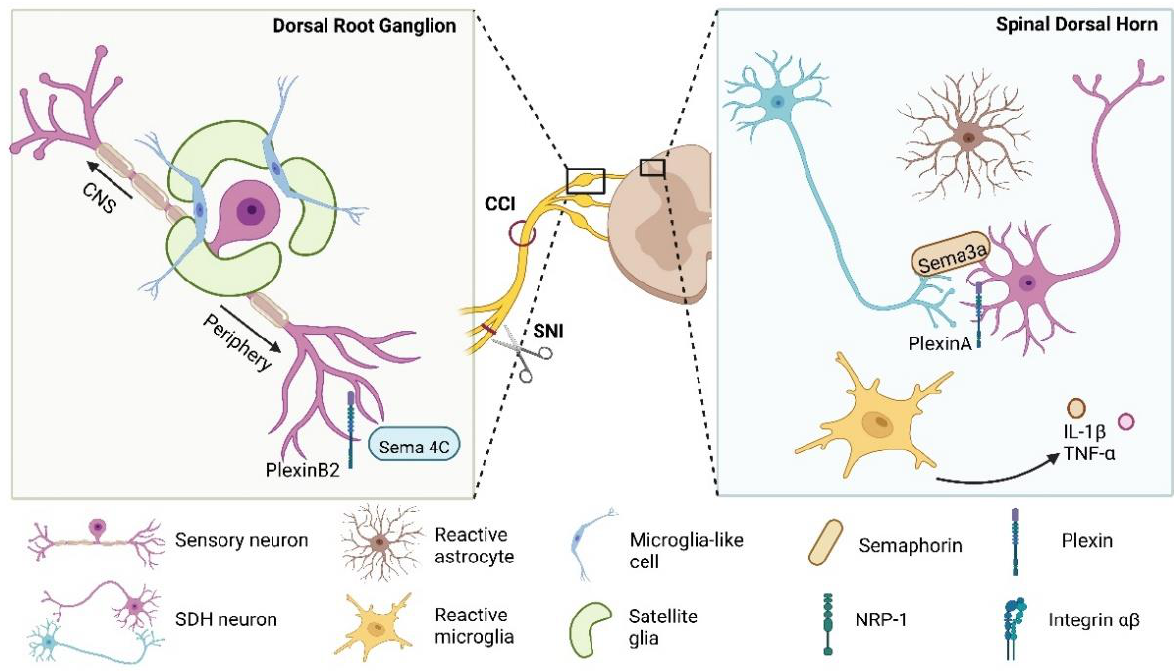
Figure 3. Semaphorin–plexin signaling in mice model of pain. Schematic representation of known semaphorins and their receptor expressed in dorsal root ganglia and the spinal dorsal horn after nerve injury in pain models of mice. CCI, chronic constriction injury; SNI, spared nerve injury; NRP- 1, Neuropilin-1; Sema, Semaphorin; IL- 1β, Interleukin - 1β; TNF - α, Tumor necrosis factor alpha.